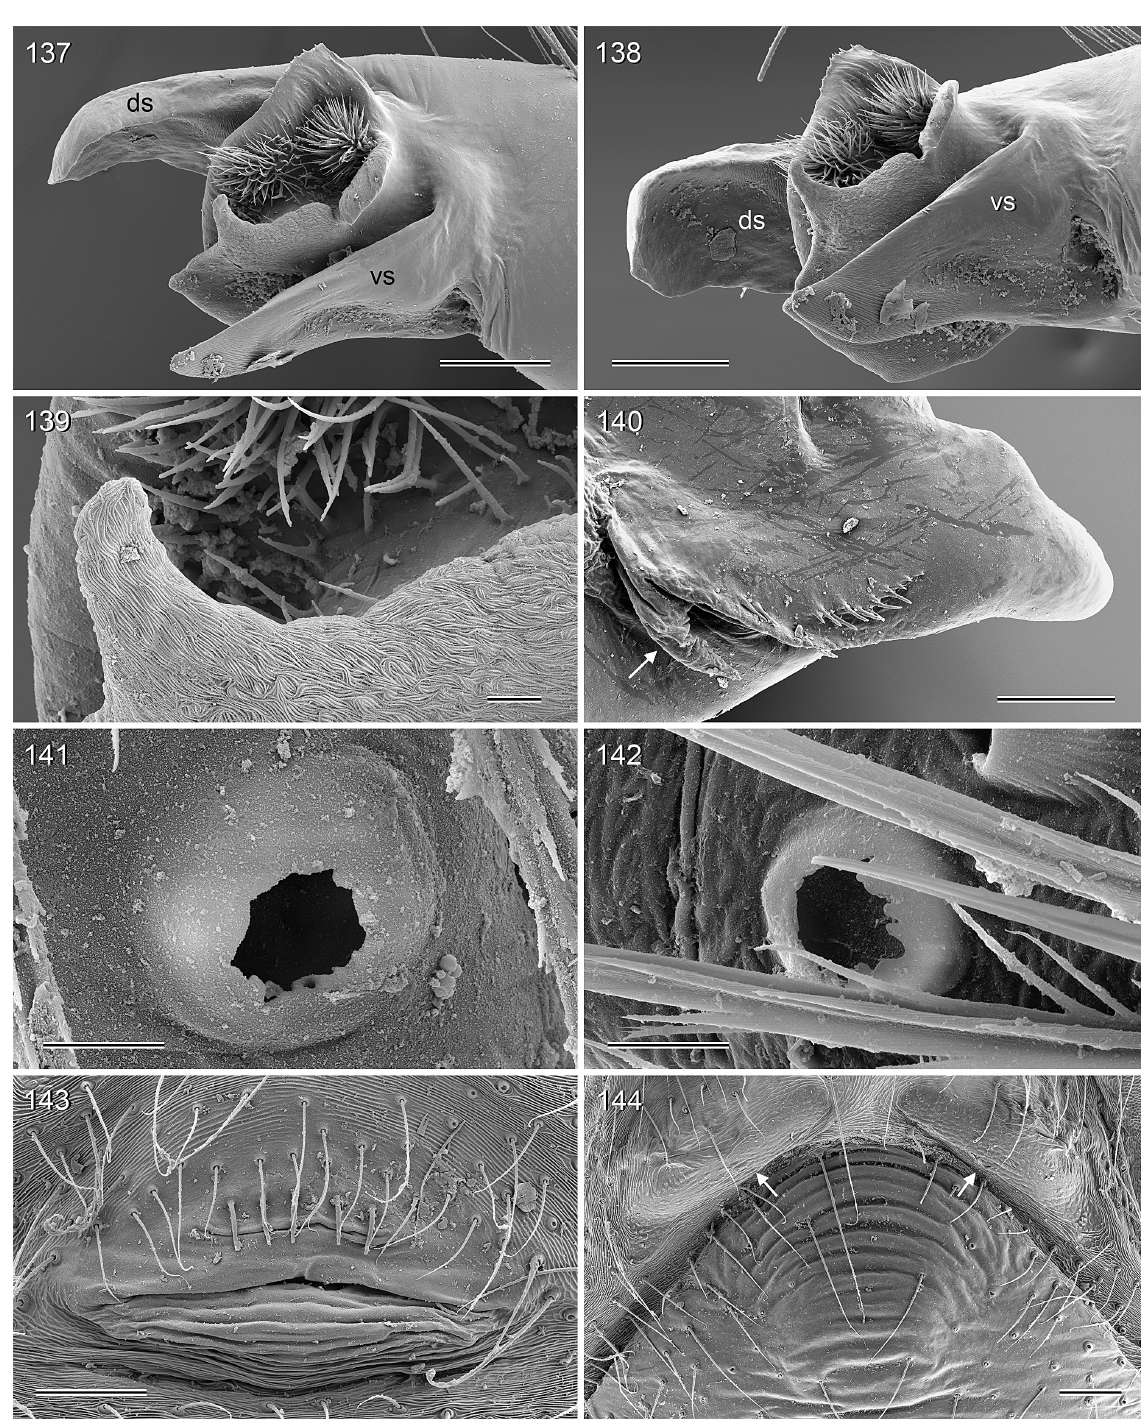
Figs 137–144. Stygopholcus photophilus Senglet, 1971; male and female from Choumerion/Pérama, Crete (MHNG). 137–138 . Tip of left procursus, retrolateral (slightly ventral) and ventral views. 139 . Detail of previous figure. 140 . Dorsal bulbal process and transparent bulbal process (arrow); note hair-like structures on dorsal bulbal process. 141 . Female palpal tarsal organ. 142 . Tarsal organ on female tarsus 4. 143 . Male gonopore and epiandrous spigots. 144 . Anterior part of epigynum showing strong ridges; arrows point at pair of anterior bulges. Abbreviations: ds = dorsal sclerite; vs = ventral sclerite. Scale bars: 137–138, 140, 143–144 = 100 µm; 139, 141–142 = 10